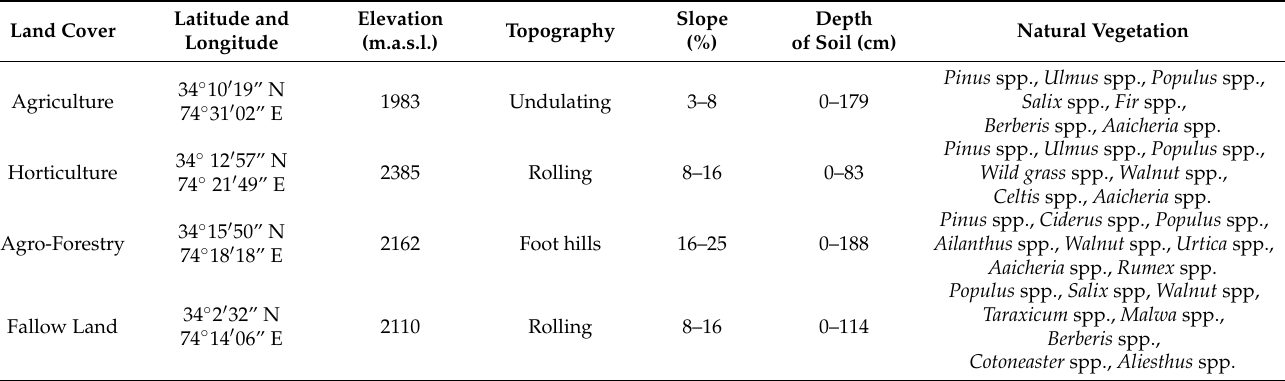
Table 1. Site characters and natural vegetation of the study